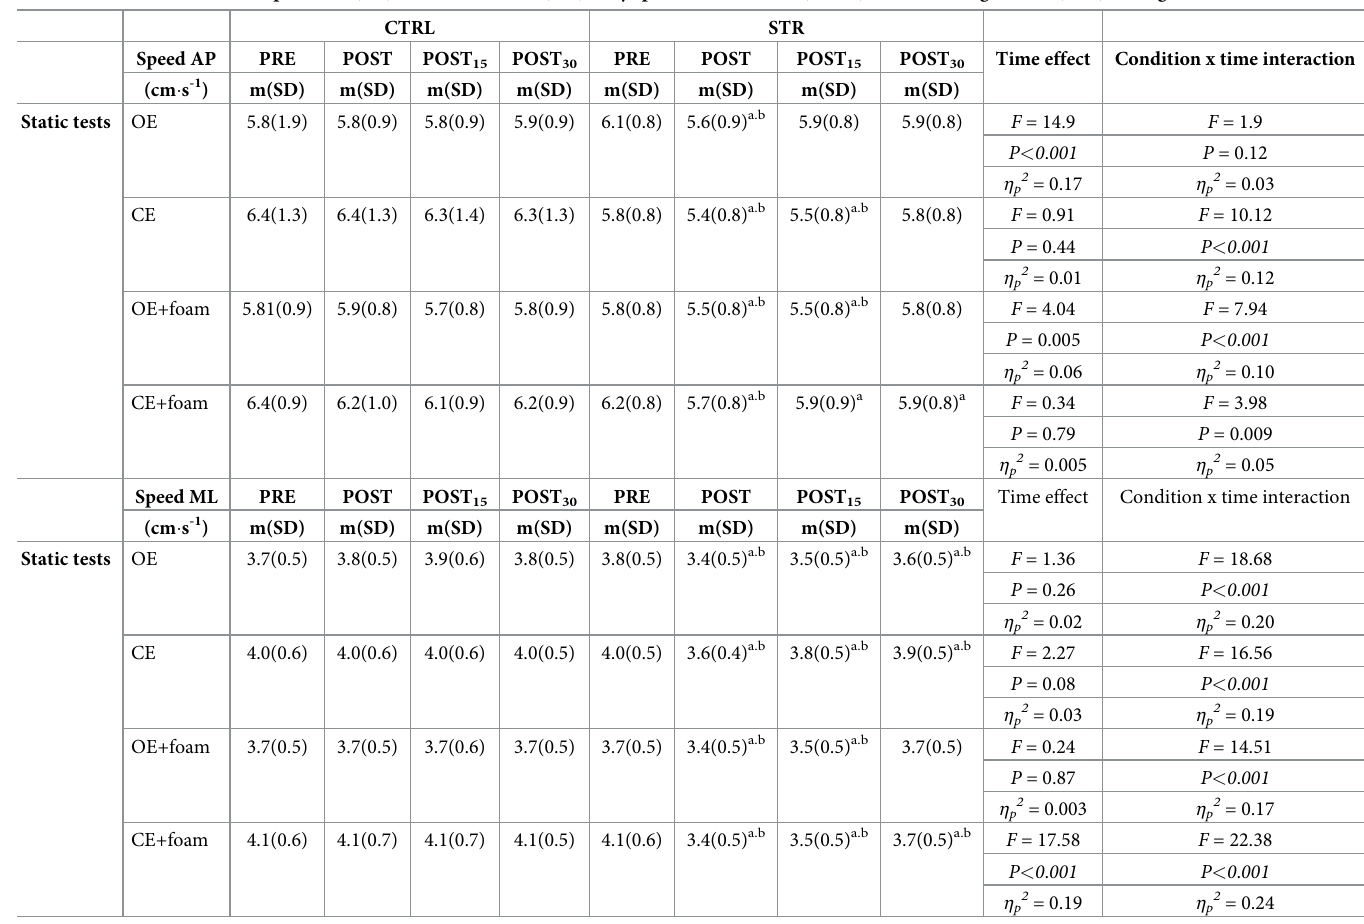
Table 5. Time course of anteroposterior (AP) and mediolateral (ML) sway speed in the control (CTRL) and stretching session (STR) during the static